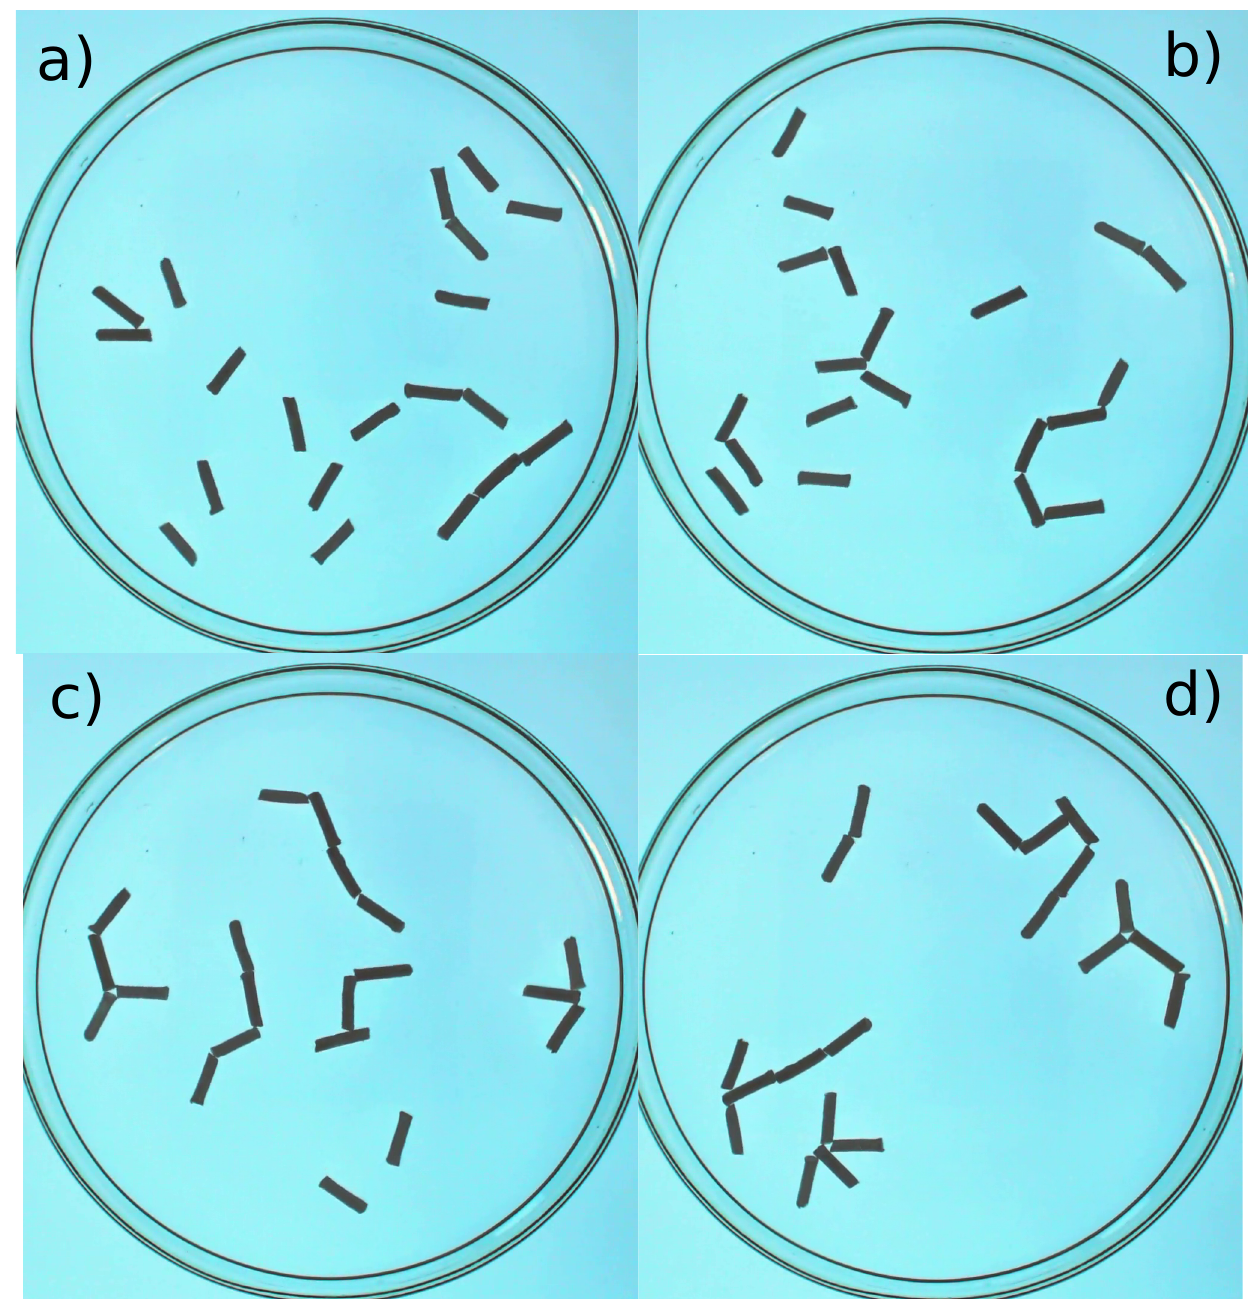
Figure 17. The time evolution of 20 rods that were 1 cm long on the water surface in a Petri dish with the diameter of 19 cm. The rods were made of 10% polypropylene, 45% camphene, and 45% camphor. The snapshots ( a – d ) correspond to the times—5 s, 30 s, 100 s, and 200 s—after all rods were placed on the surface. The movie showing the time evolution is included in the Supplementary Information as